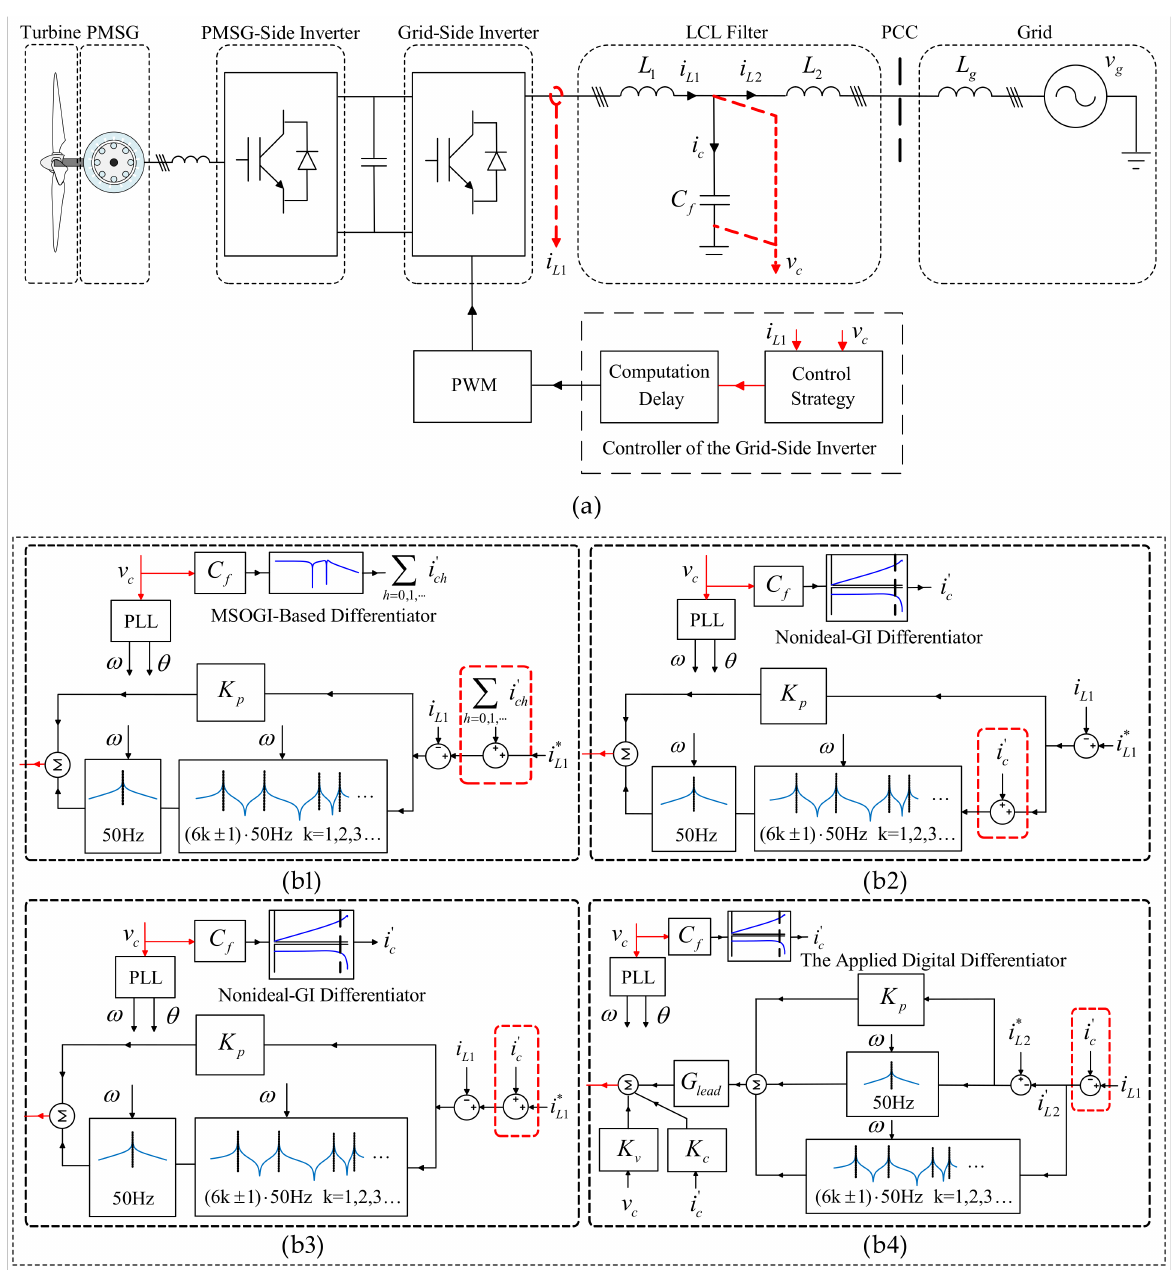
Figure 1. A three-phase balanced wind power generation system: ( a ) Single-phase equivalent circuit; ( b1 – b4 ) control block diagrams of the grid-side